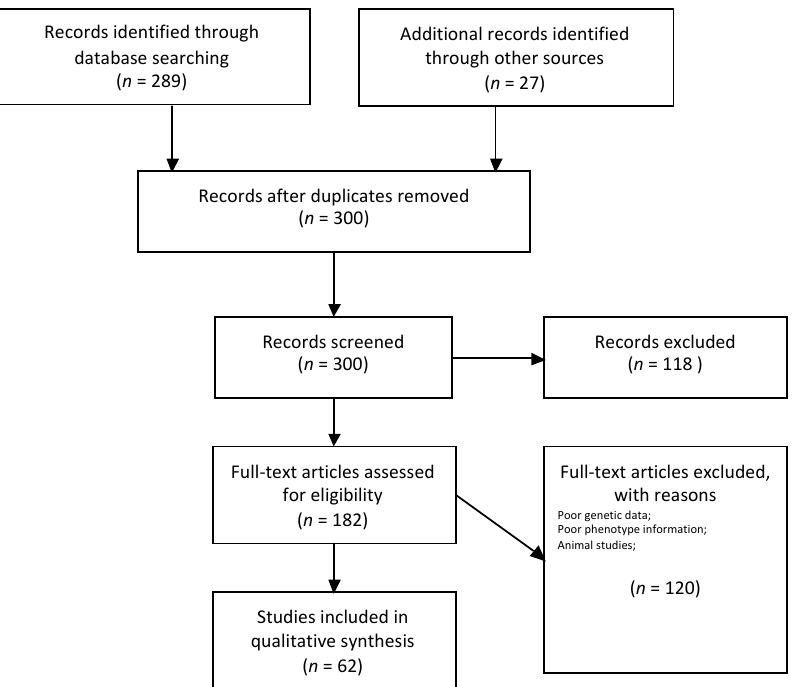
Figure 1. Flow diagram for article selection.